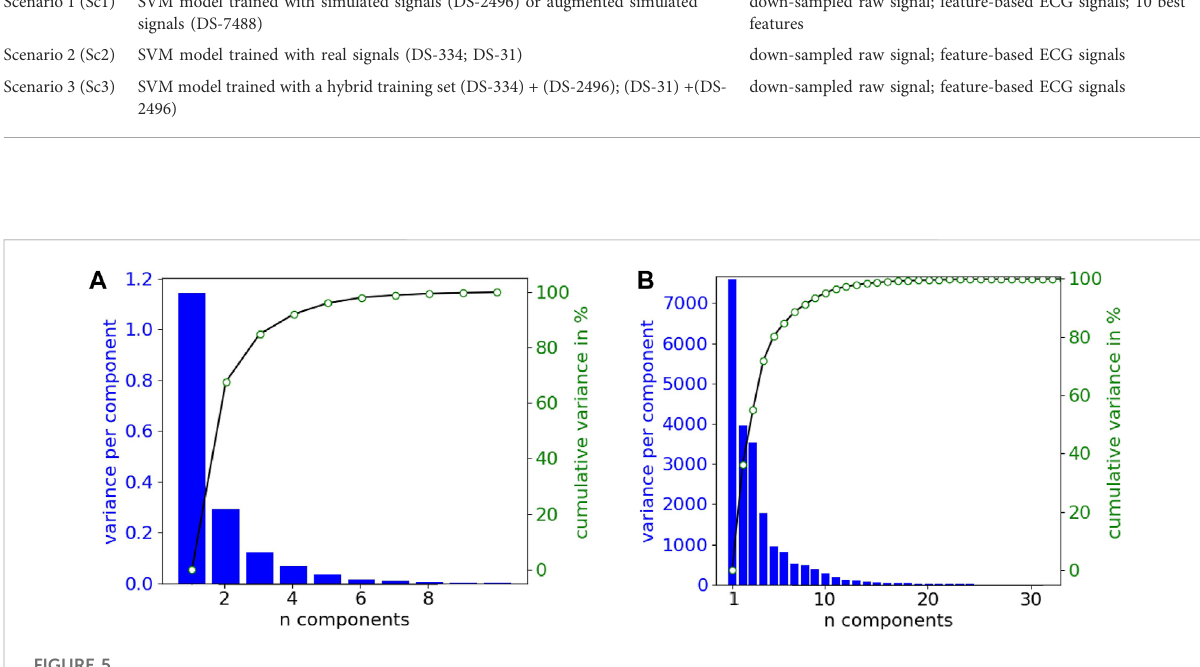
FIGURE 5 Varianceexplainedbytheprincipalcomponentsfromthesimulateddataset(DS-2496). (A) Down-sampled rawsignals(10samplesorfeatures). (B) Featured signals (356